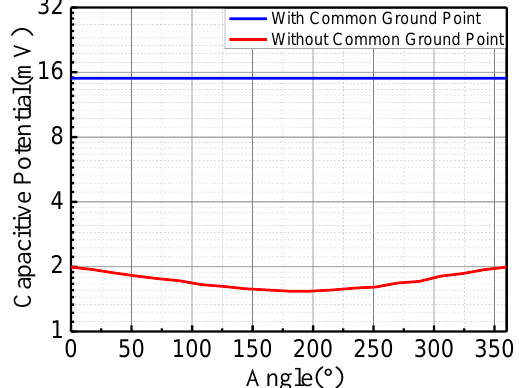
Figure 12. Influence of grounding mode.